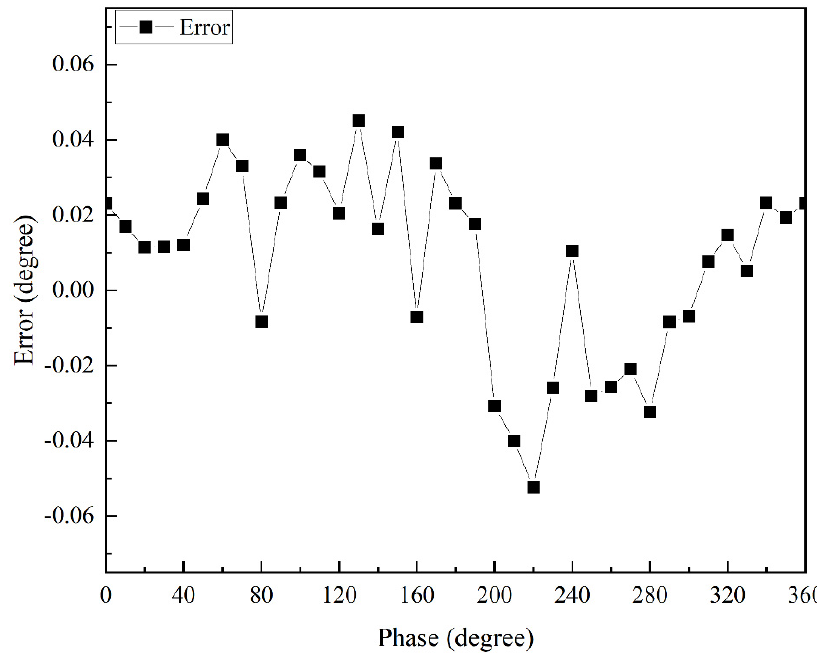
Figure 8. Accuracy of